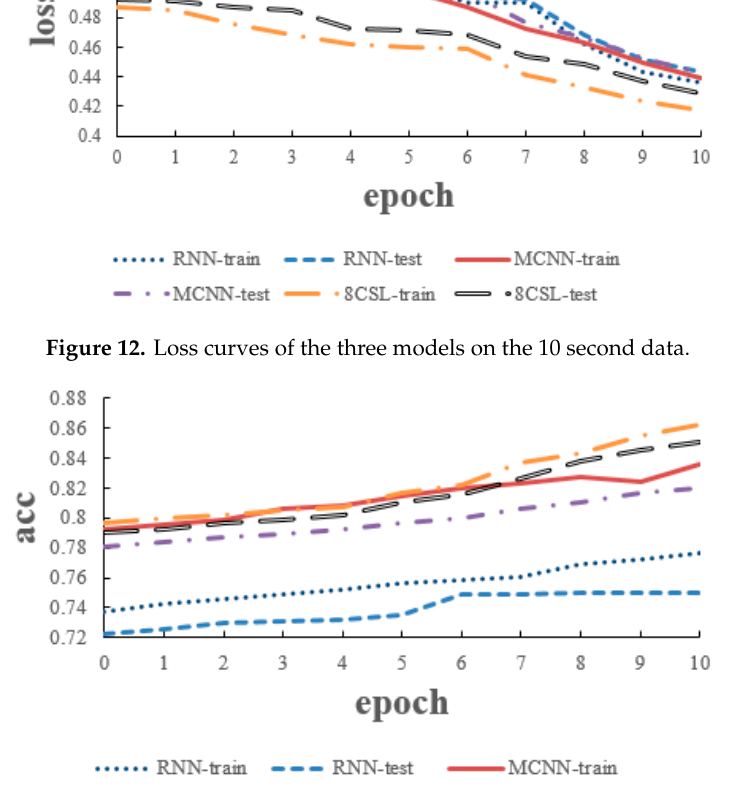
Figure 14. Loss curves of the three models on the 20 second data.